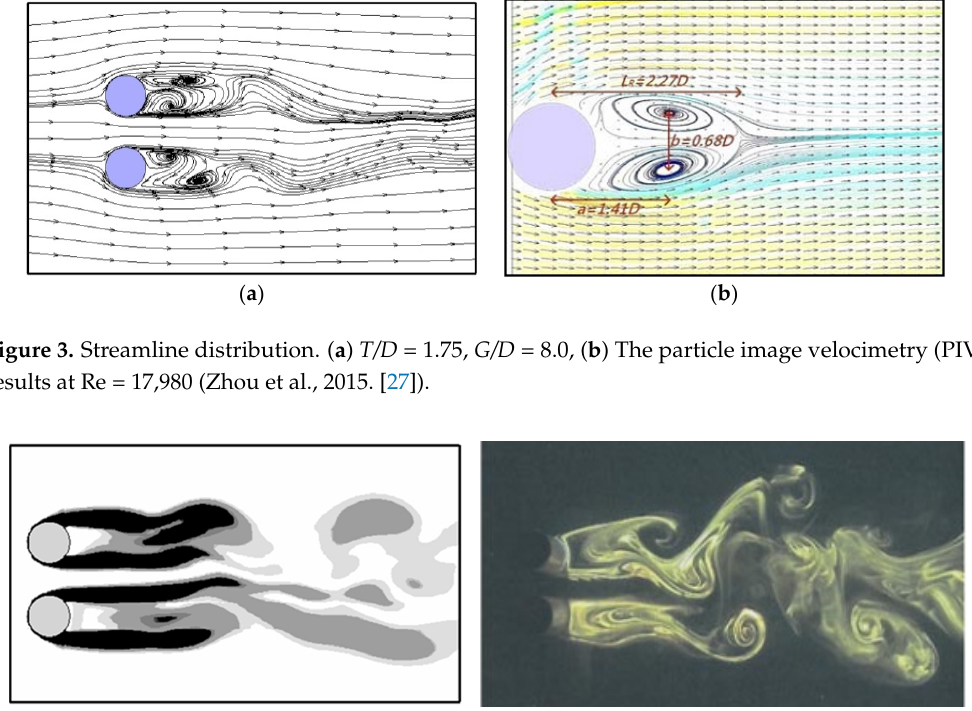
Figure 4. Instantaneous span ‐ wise vorticity distributions. ( a ) T/D = 1.75, G/D = 8.0, ( b ) The results of PIV, T/D = 1.80 (Zhou et al., 2001. [28]).